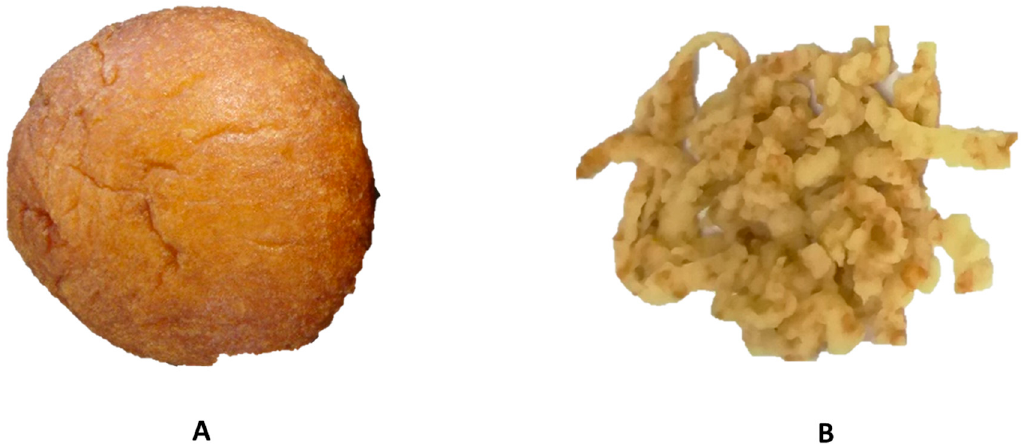
Figure 1. Whole ( A ) and minced ( B ) fried batter.